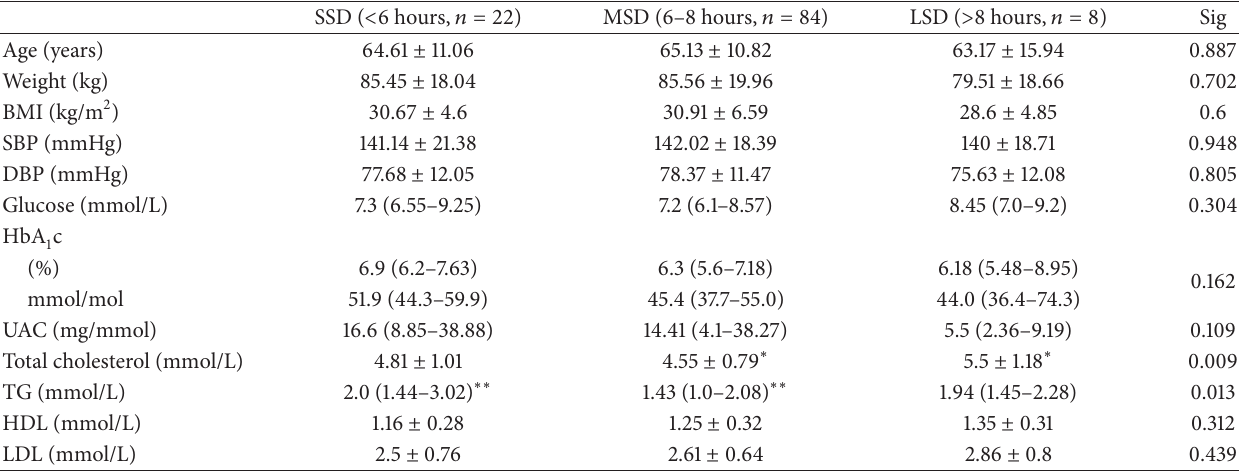
Table 2: Characteristics based on sleep